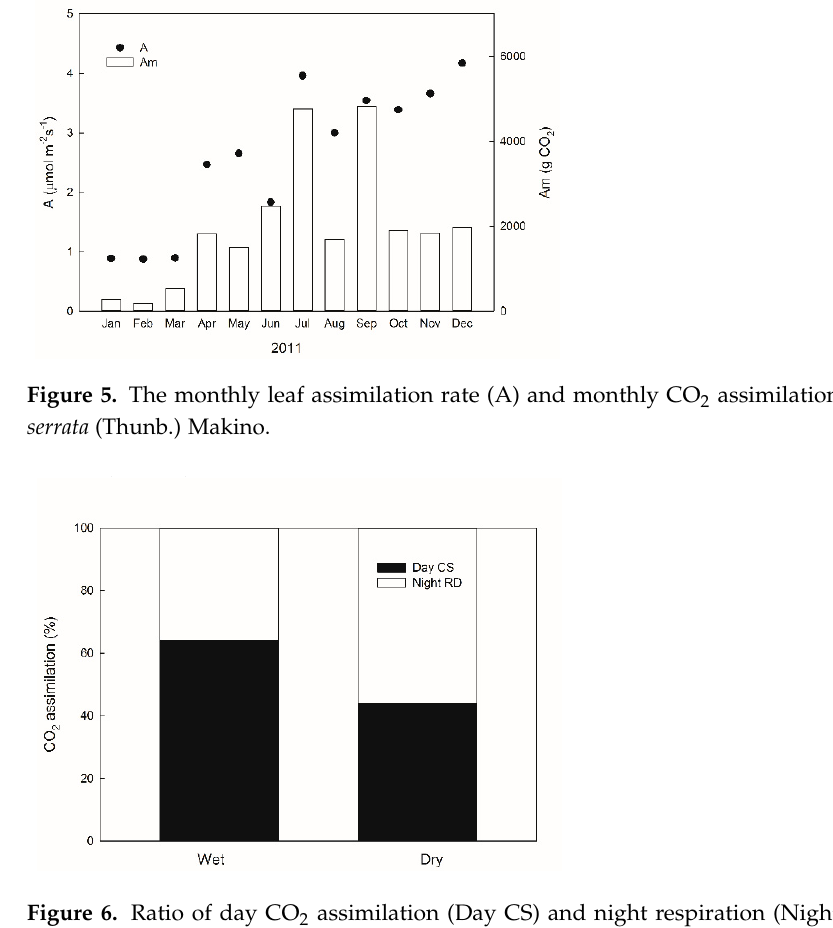
Figure 6. Ratio of day CO 2 assimilation (day CS) and night respiration (night RD) in wet and dry seasons.